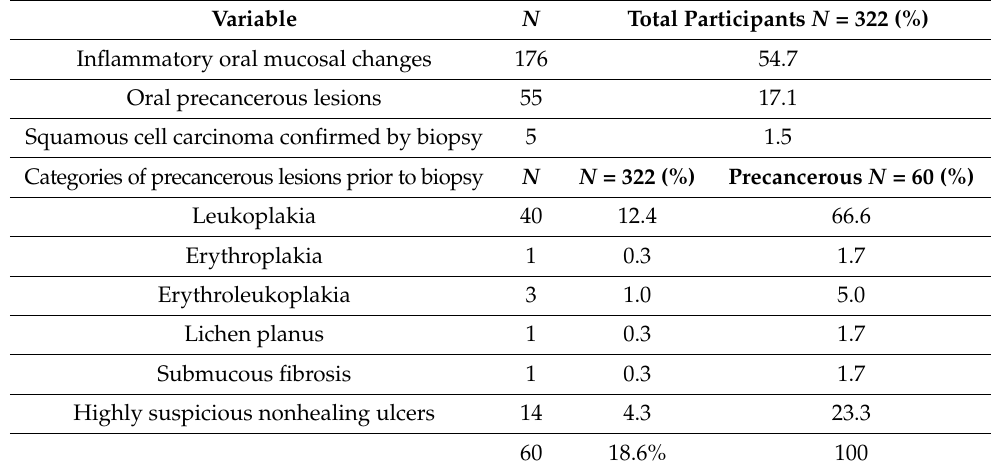
Table 5. Oral mucosal screening (participants: N =